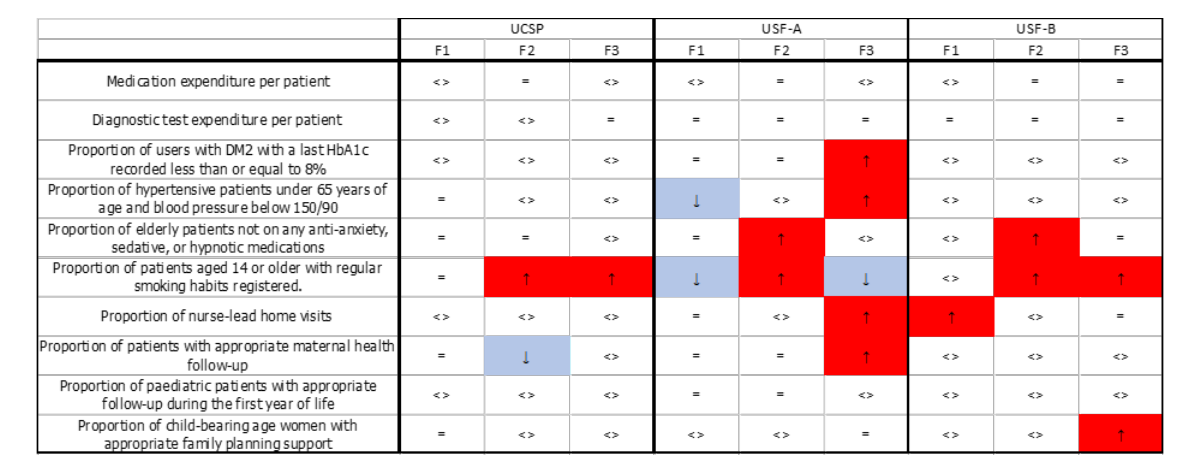
Figure 1. Summary of differences in results in distinct socio-economic contexts before and after commissioning by factors and indicators. Legend: <> differences before commissioning remain equal; = the absence of differences before commissioning remains; ↓ differences before commissioning decrease; ↑ differences before commissioning increase.